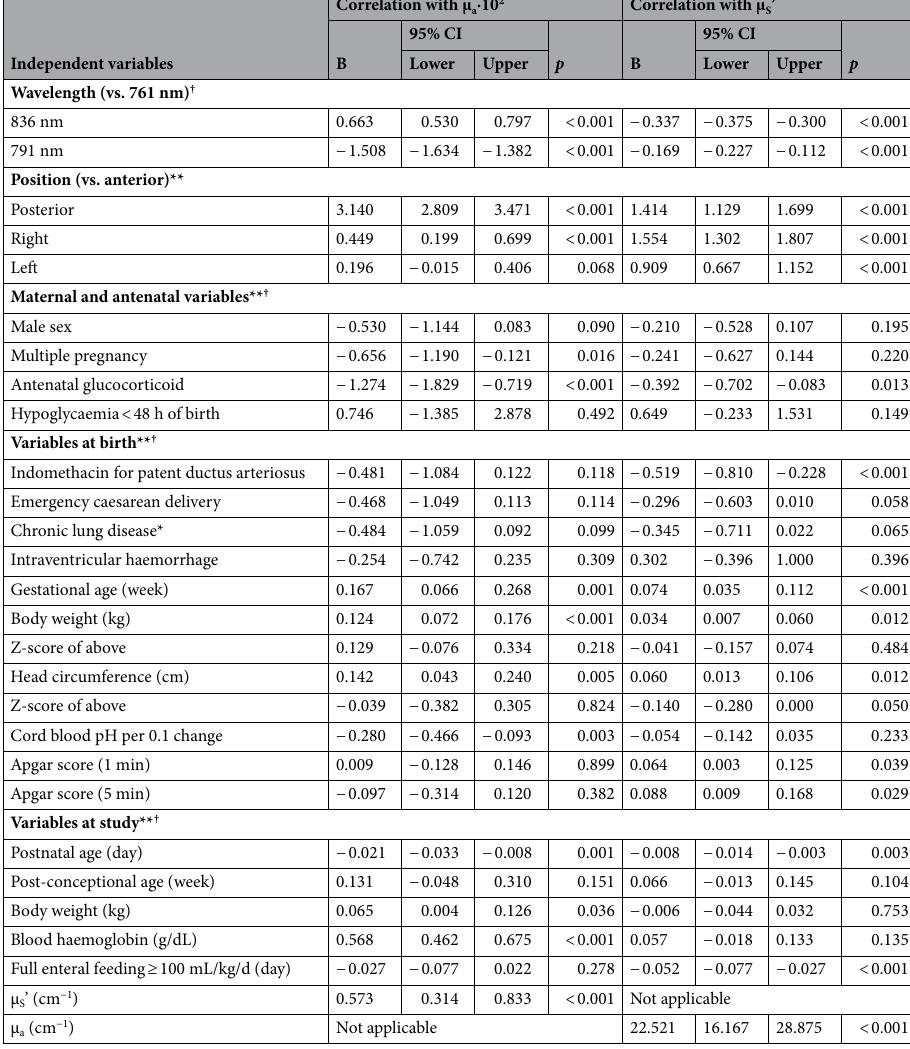
Table 2. Dependence of µ a and μ S ’ on clinical variables: univariate analysis. B regression coefficient, CI confidence interval, µ a absorption coefficient, µ s ’ reduced scattering coefficient. *Assessed at 36 weeks post- conceptional age (or on day 28 for those born later than 32 weeks gestation). Findings are adjusted for the wavelengths of near-infrared light** and position of the head †